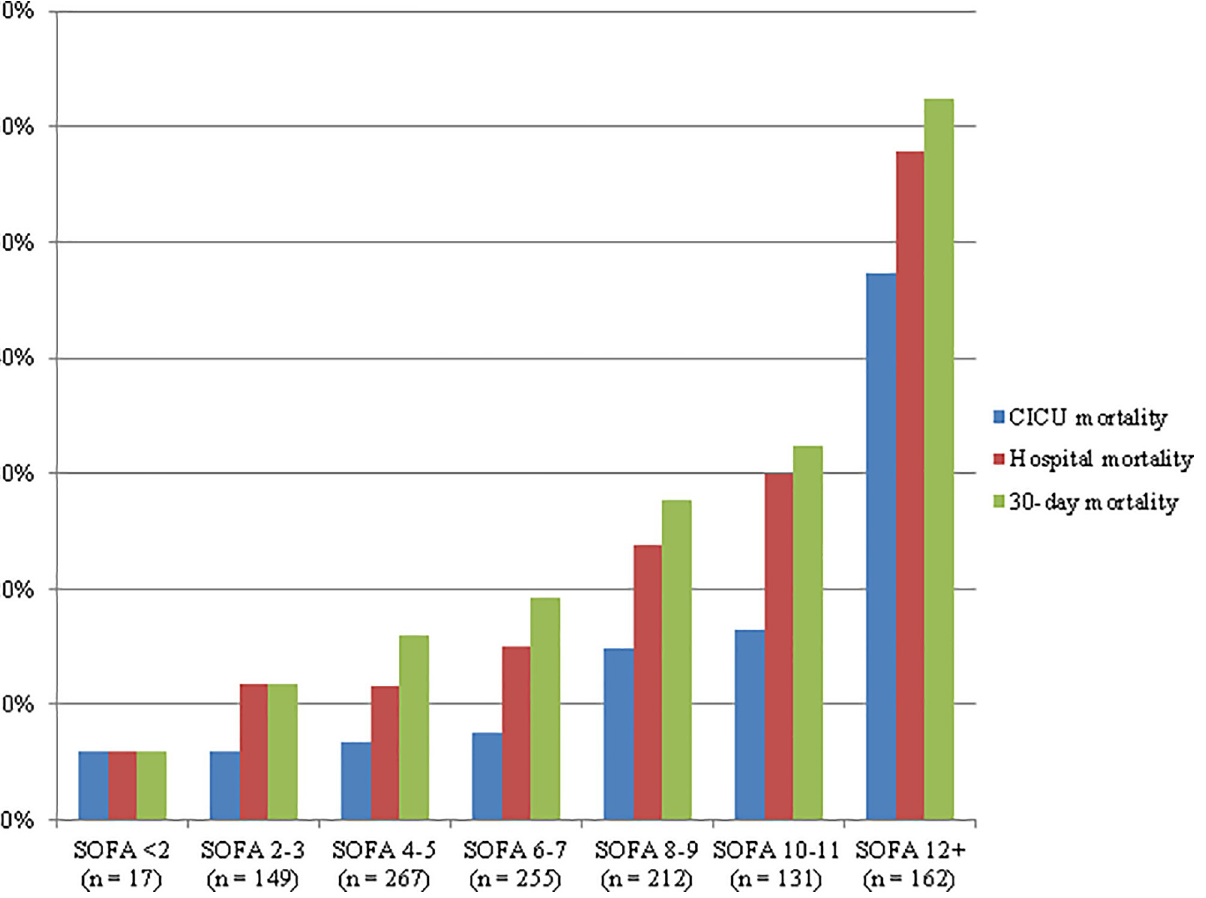
Fig 1. Short-term mortality as a function of Day 1 SOFA score in the final study population. P < 0.001 for trend.